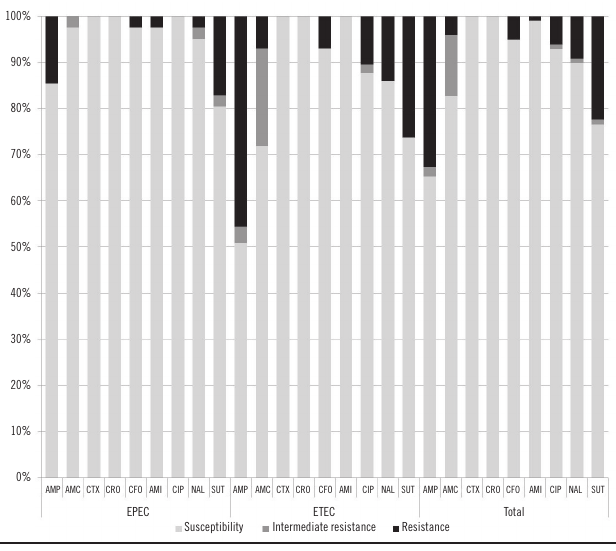
figurE − Antimicrobial resistance susceptibility profile of ETEC and EPEC samples isolated from fecal specimens of children with acute